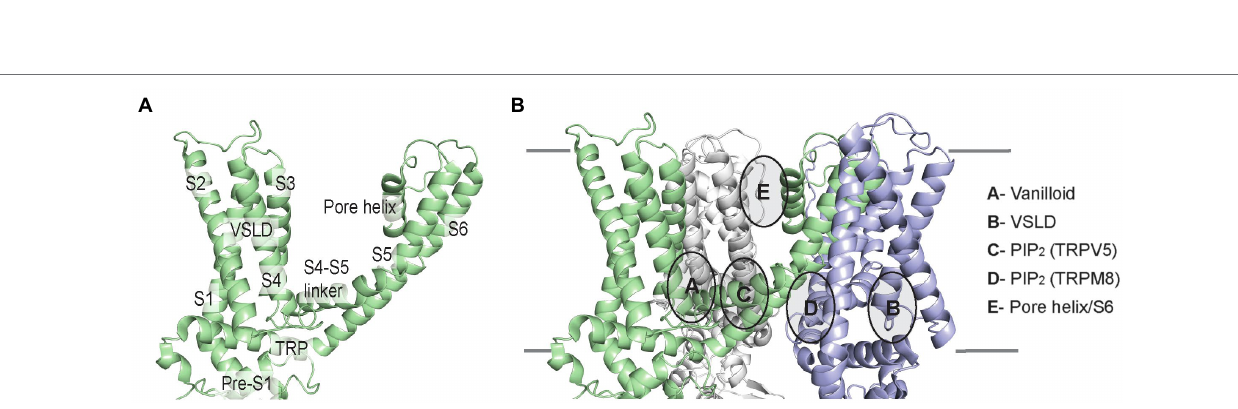
FIGURE 5 | Inner leaflet M3/M4 intrasubunit binding site (A) GLIC- α 1GABA A R with pregnenolone sulfate (pdb 5osc). (B) α 1 β 3 γ 2 GABA A R with PIP 2 bound to the α 1 subunit (pdb